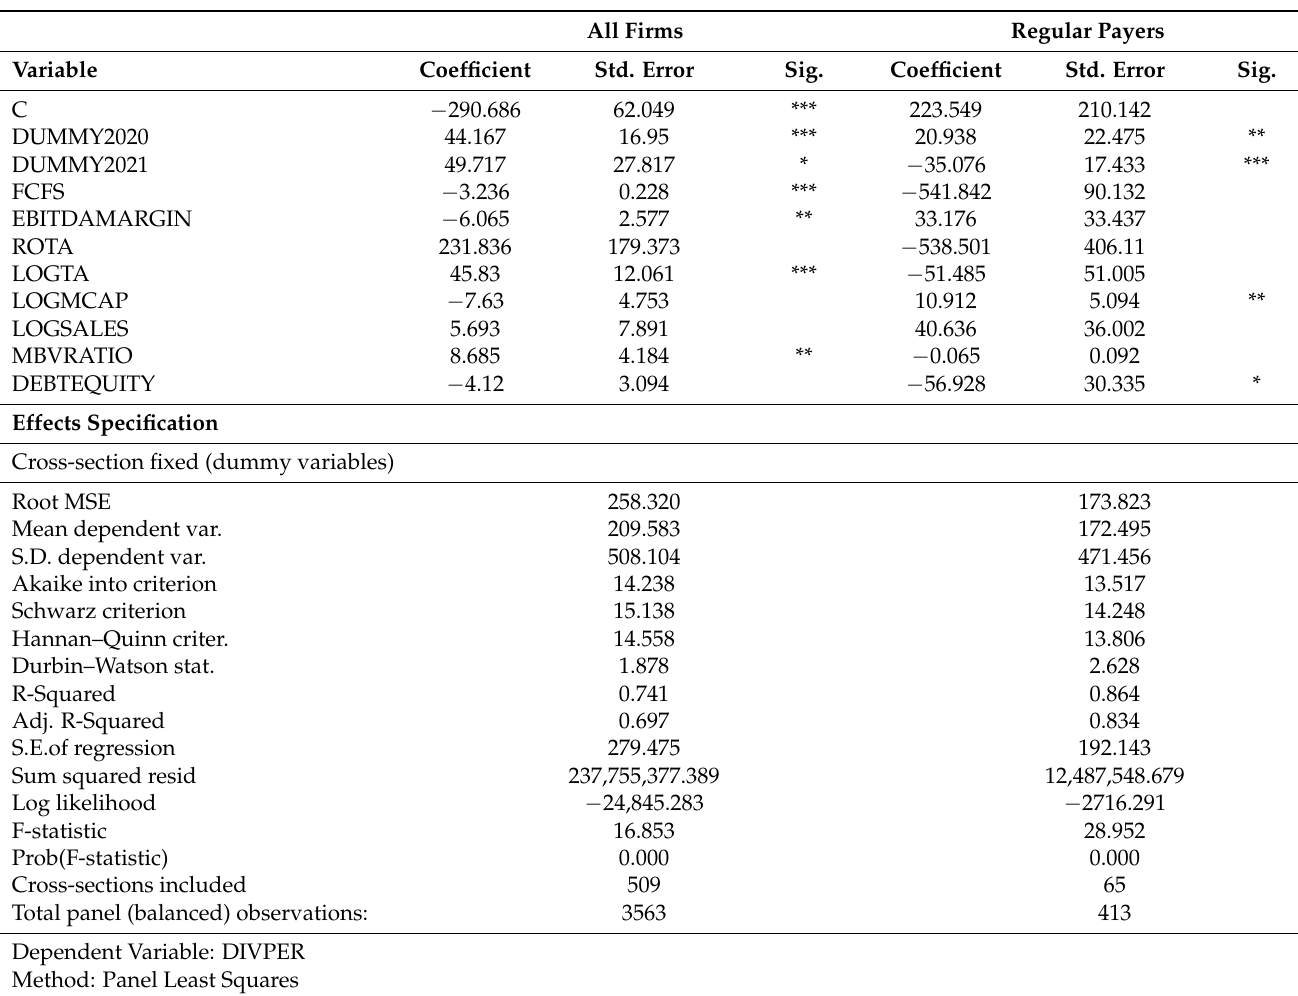
Table 8. Determinants of changing payouts (results of panel regression with cross-section-fixed and panel-clustered